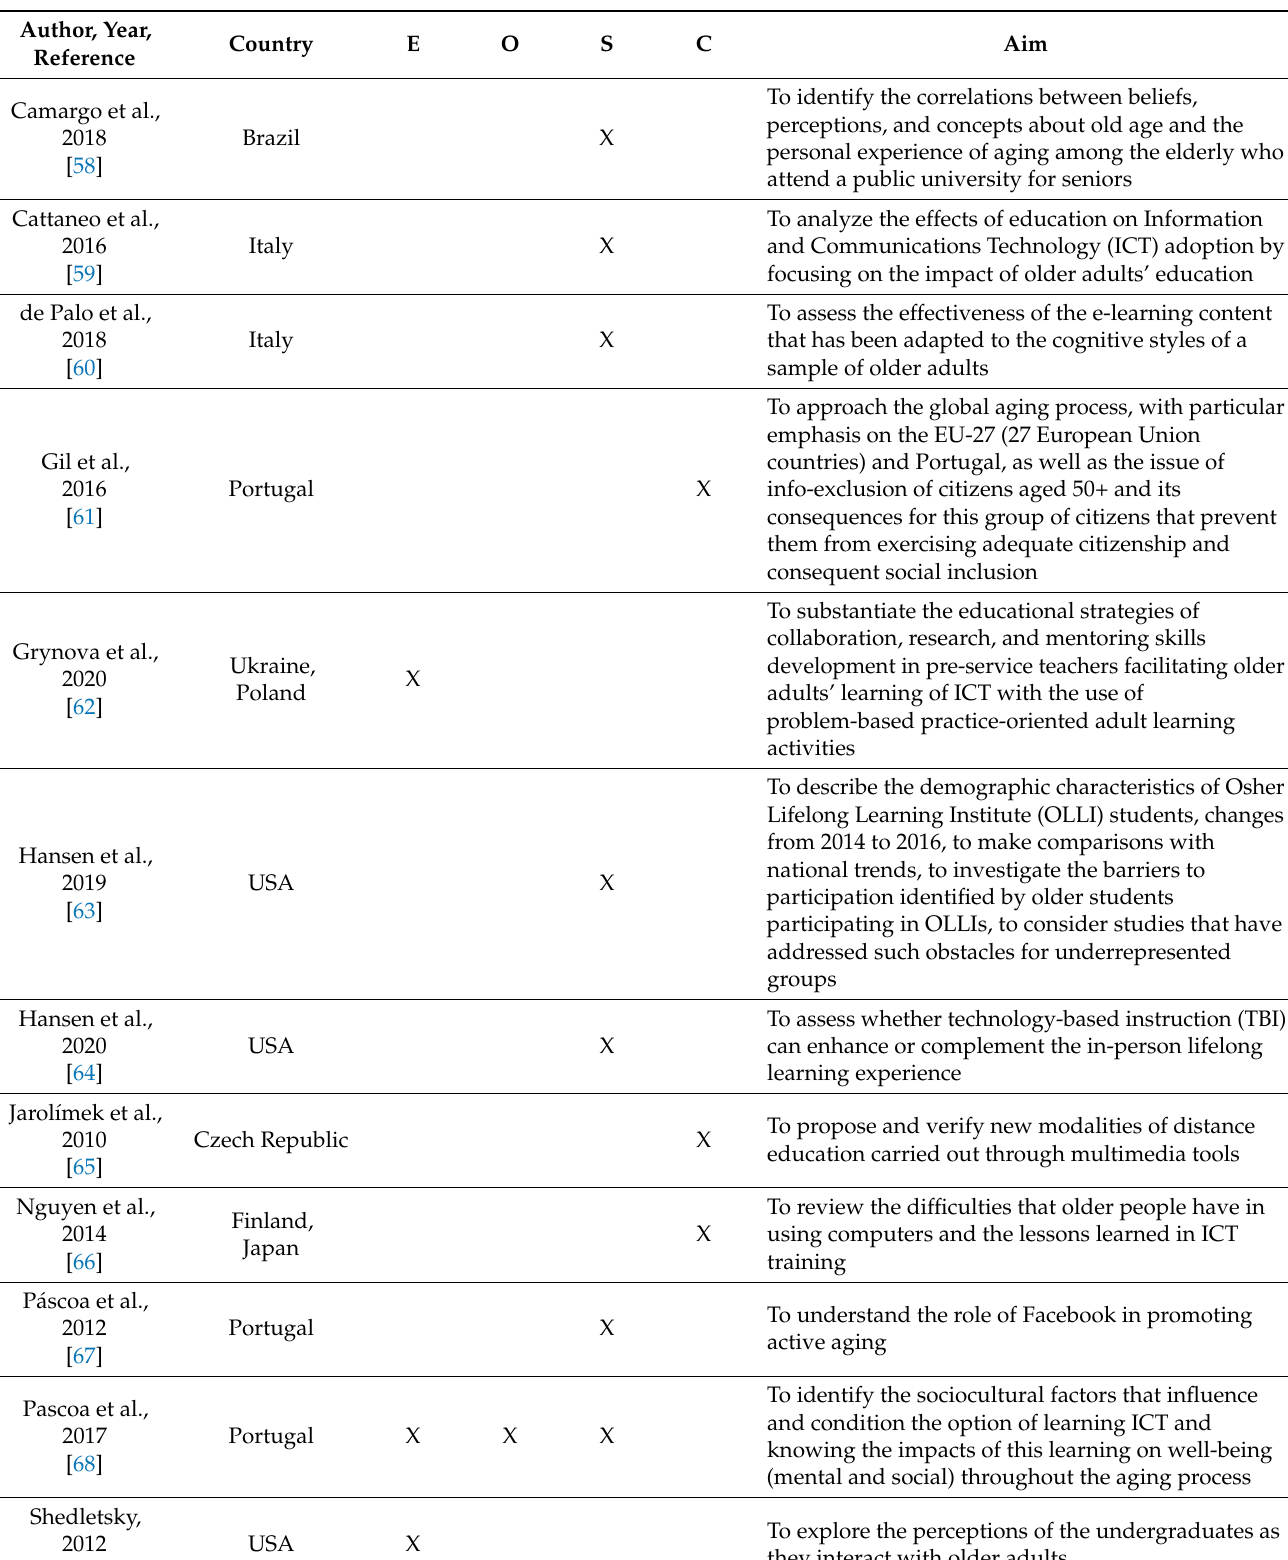
Table 1. References, country, focus, and aim of the 18